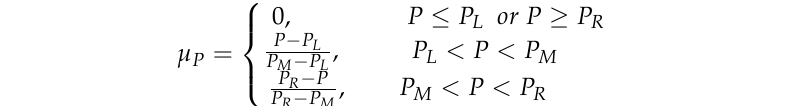
4 of 23 Figure 1. Graphical representation of the load as a triangular fuzzy number.